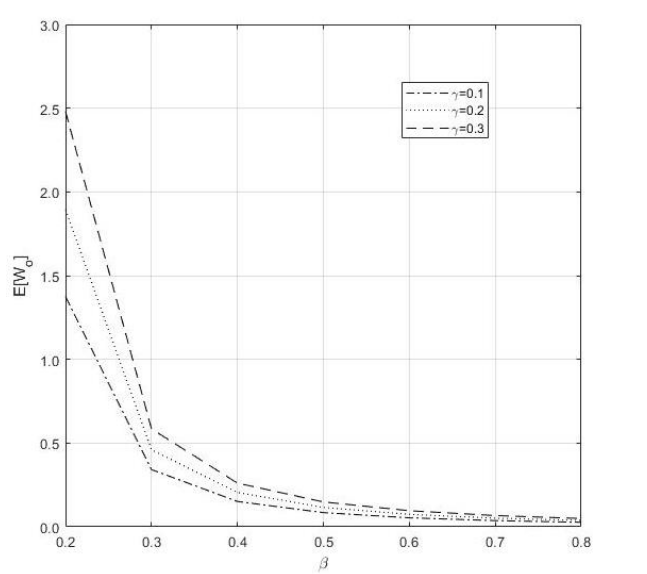
Figure 2. Impact of γ and β on the E [ W o ]